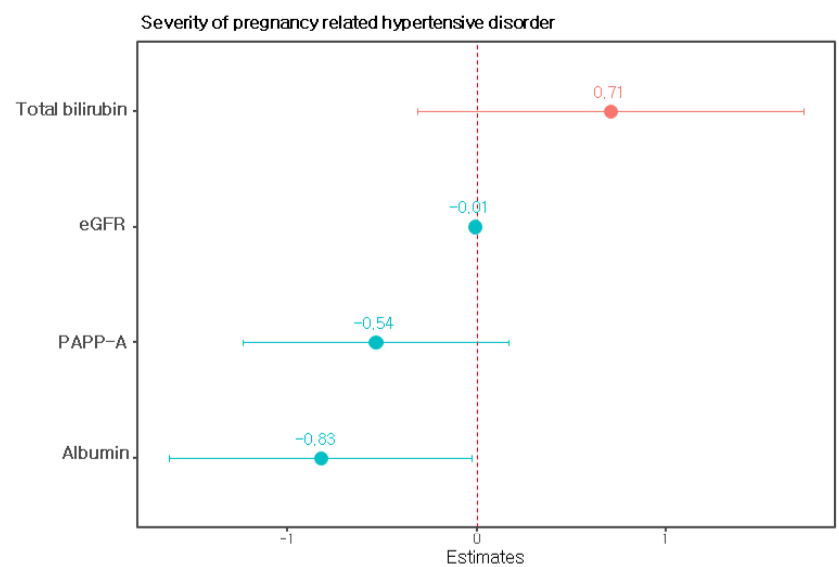
Figure 1. Regression coefficients of the model predicting the severity of pregnancy-related hyperten- sive disorders. Note: PAPP-A, pregnancy-associated plasma protein-A; eGFR, estimated glomerular filtration rate. Table 4. Histopathological factors related to the severity of pregnancy-related hypertensive disorders by linear regression analysis.